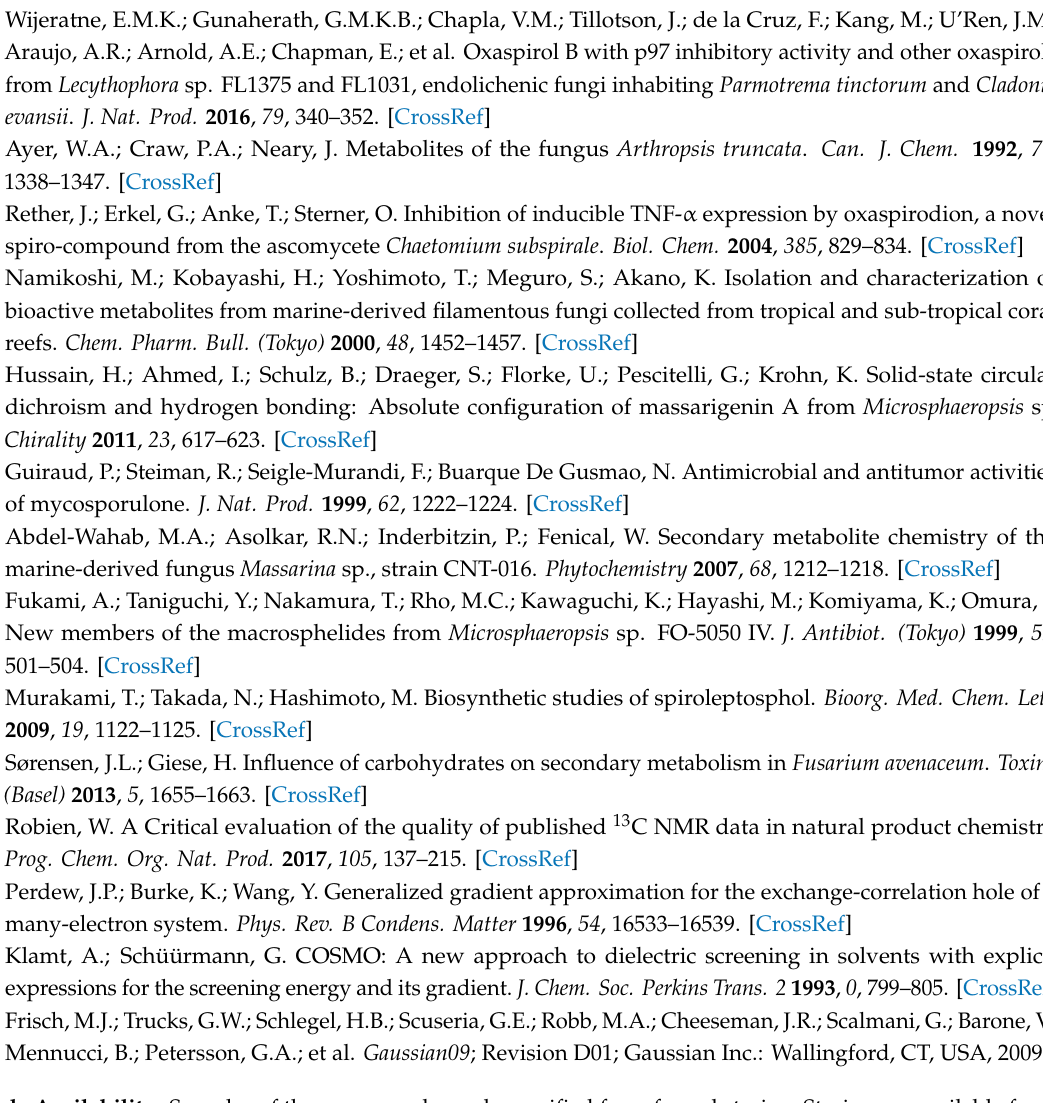
Sample Availability: Samples of the compounds can be purified from fungal strains. Strains are available from the